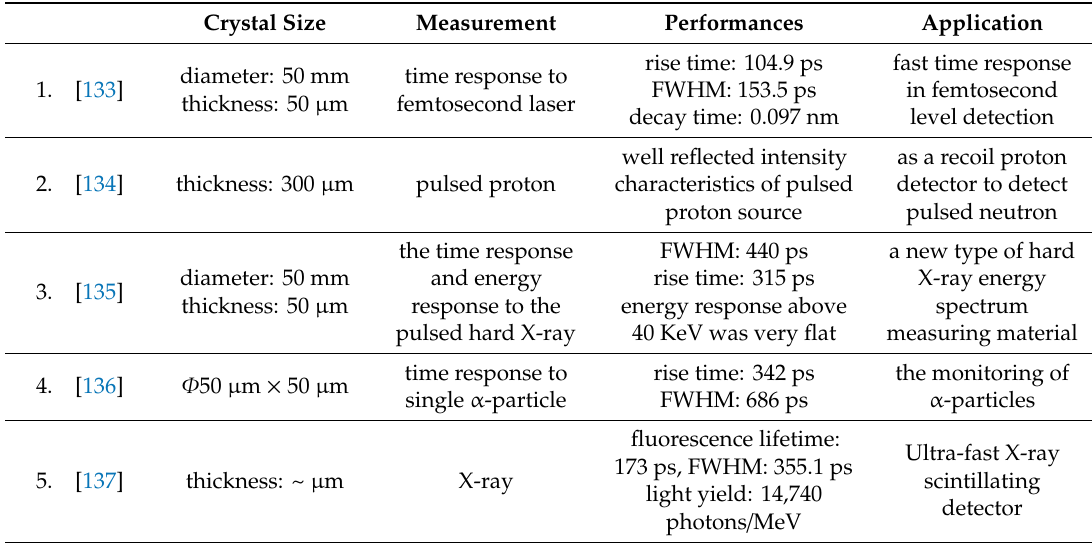
Table 7. The application of ZnO:Ga scintillation crystals prepared by magnetron sputtering in radiation detection. Crystal Size Measurement Performances Application